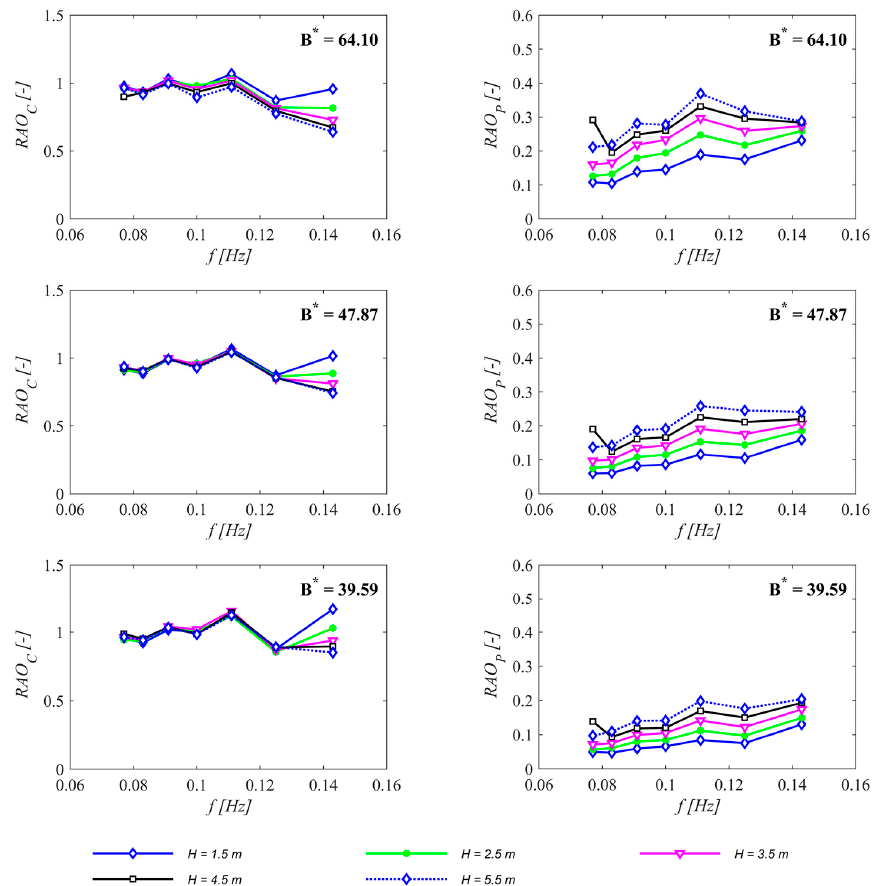
Figure 13. Variation of the response amplitude operator (RAO) for the free surface elevation and the differential pressure between inside the OWC chamber and the atmosphere ( RAO C and RAO P respectively) with the wave frequency ( f ) for regular waves (Series A); and for different values of the wave height ( H ) and damping coefficient ( B * ) (prototype data).